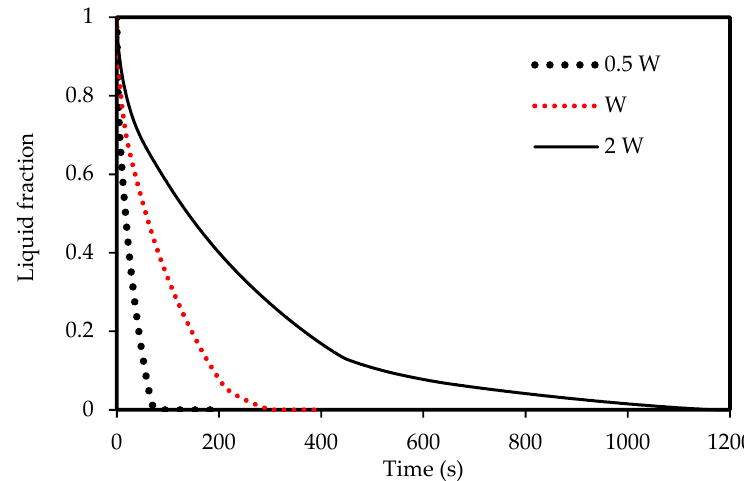
Figure 14. The liquid-fraction evolution of the solidification process in the horizontal corrugated channel for different widths.